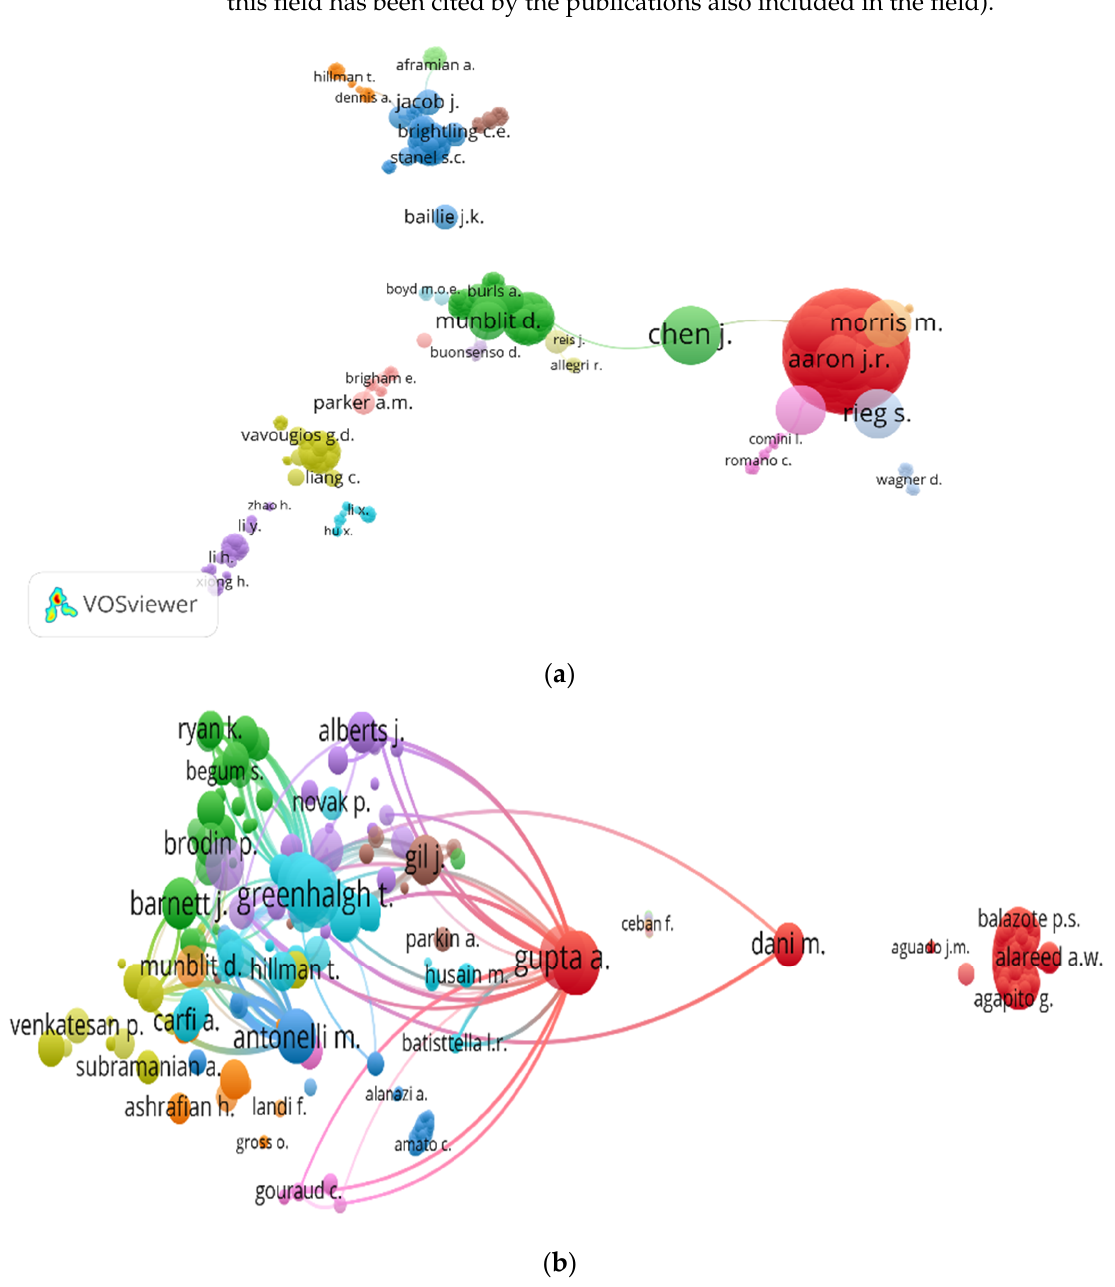
Figure 4. Network visualization map for ( a ) author co-authorship map; ( b ) author co-citation map.